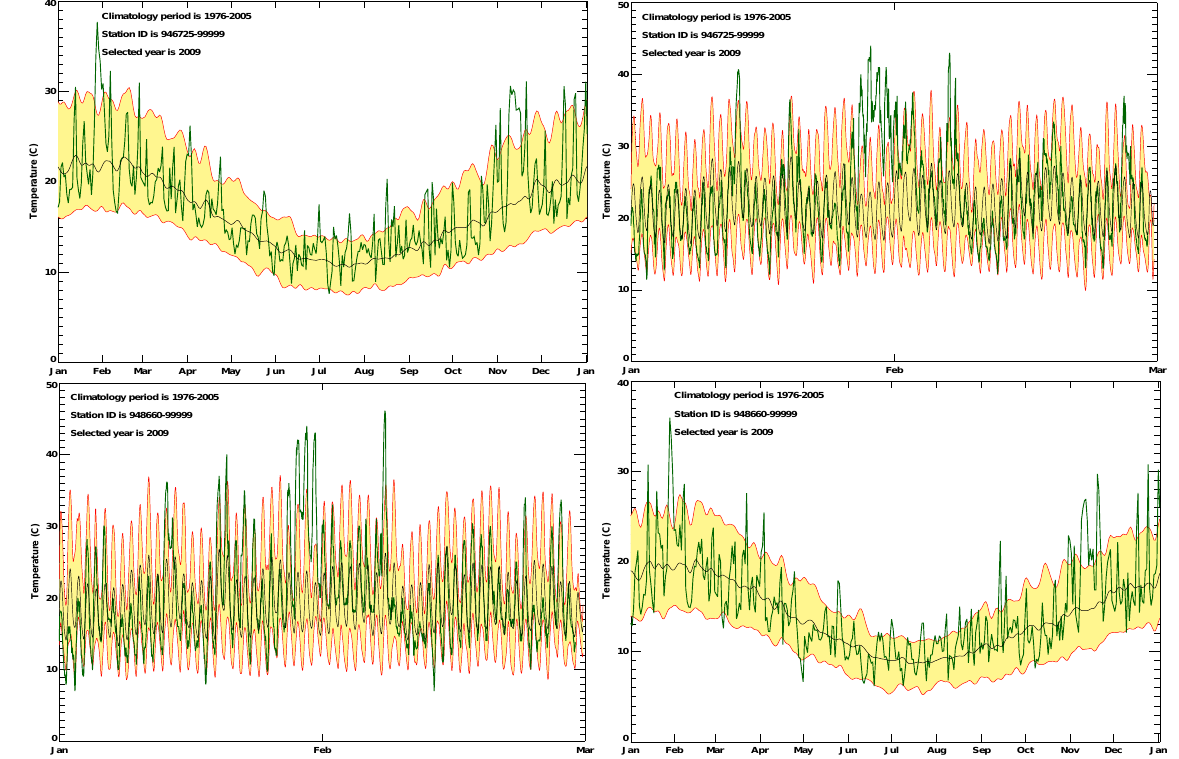
Fig. 19. Left: daily mean temperature in southern Australia in 2009 (green curve) with climatological average (black line) and 5th and 95th percentiles (red lines and yellow shading). The exceptionally high temperatures in late January/early February and mid-November can clearly be seen. Right: similar plots showing the full sub-daily resolution data for a two month period starting in January 2009. The climatology, 5th and 95th percentile lines have been smoothed using an 11-point binomial filter in all four plots. Top: Adelaide (946725-99999, 34.93 ◦ S, 138.53 ◦ E, 4m), bottom: Melbourne (948660-99999, 37.67 ◦ S, 144.85 ◦ E, 119m).